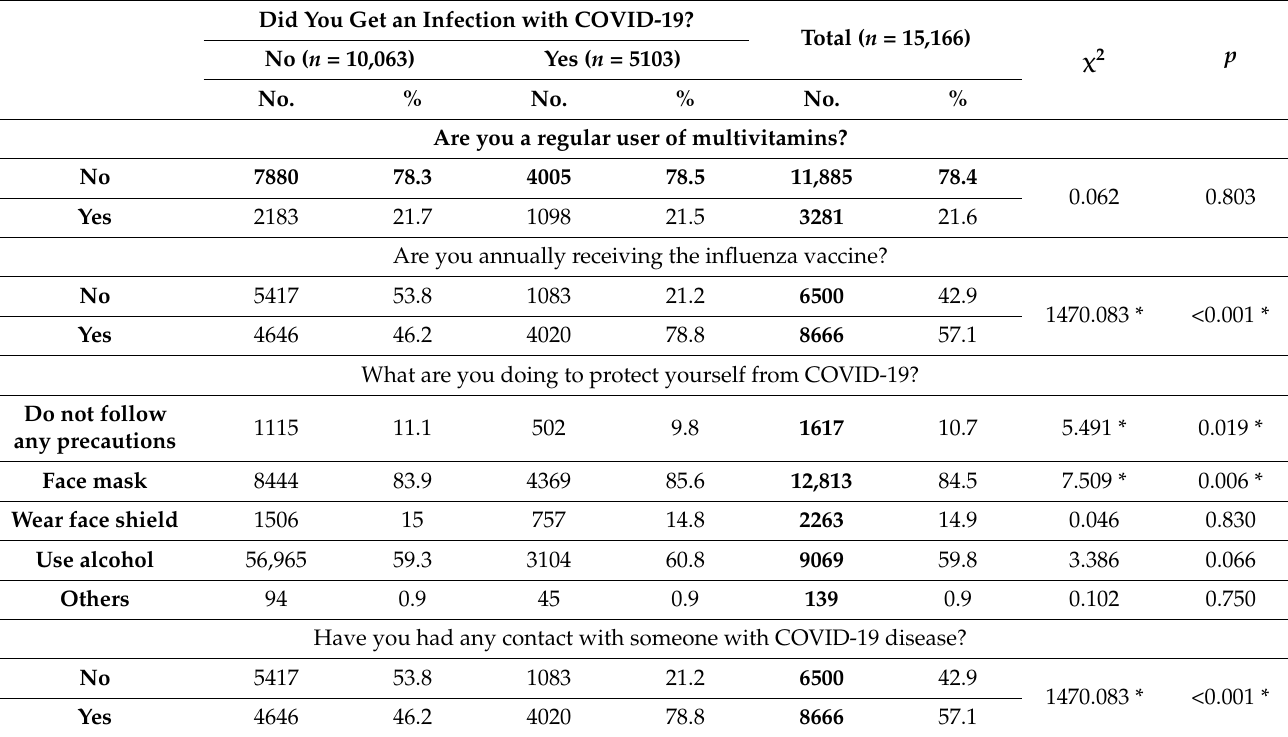
Table 4. The relation between the applied precautionary measures and the incidence of infection with COVID-19.